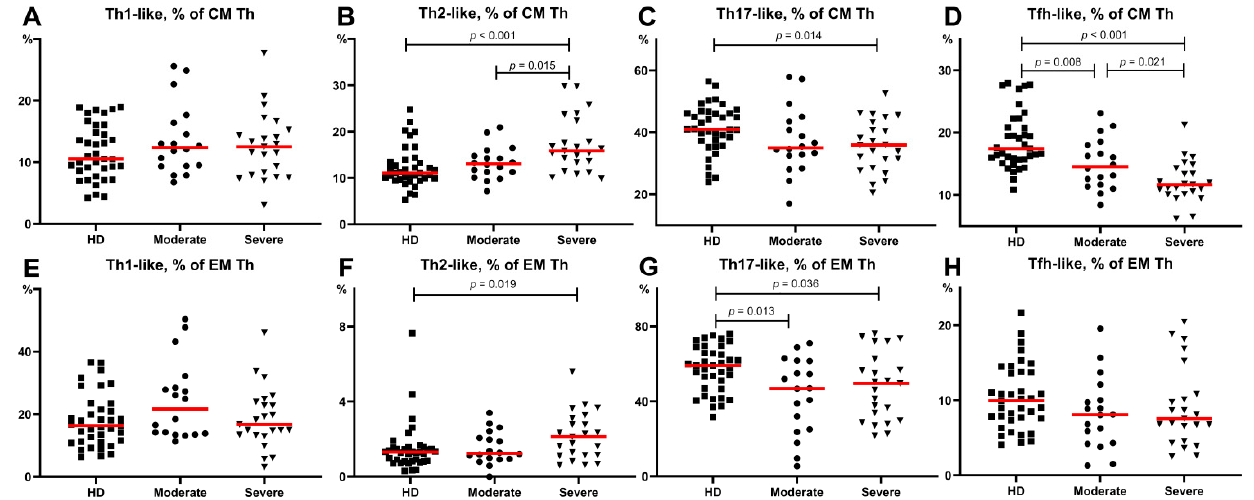
Figure 5. Th-cell subsets calculated from CM Th ( A – H ) or EM Th cells in patients with COVID-19 and in healthy donors. ( A ). Relative count of Th1-like cells calculated from CM Th cells. ( B ). Relative count of Th2-like cells calculated from CM Th cells. ( C ). Relative count of Th17-like cells calculated from CM Th cells. ( D ). Relative count of Tfh-like cells calculated from CM Th cells. ( E ). Relative count of Th1-like cells calculated from EM Th cells. ( F ). Relative count of Th2-like cells calculated from EM Th cells. ( G ). Relative count of Th17-like cells calculated from EM Th cells. ( H ). Relative count of Tfh-like cells calculated from EM Th cells. EM, effector memory; CM, central memory; Tfh, follicular Th-like cells. Red lines demonstrate Median value.